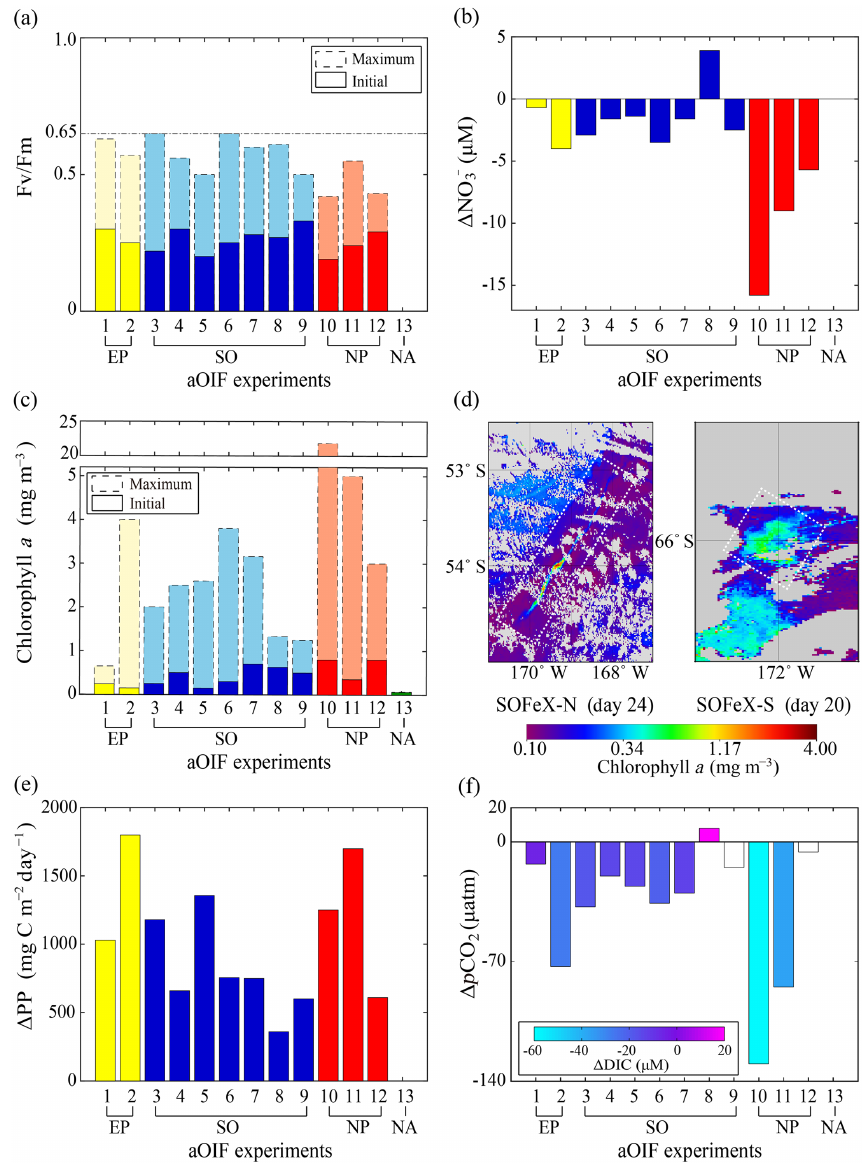
Figure 7. (a) Maximum (bar with dotted line) and initial (bar with solid line) F v /F m ratios during artificial ocean iron fertilization (aOIF) = [ NO − ] −[ NO − ] experiments. (b) Changes in nitrate concentrations ( (cid:49) NO − post − fertilization ( postf ) pre − fertilization ( pref ) ; µM). (c) Maximum 3 3 3 (bar with dotted line) and initial (bar with solid line) chlorophyll a concentrations (mgm − 3 ). (d) Distributions of chlorophyll a concentrations (mgm − 3 ) on day 24 after iron addition in the Southern Ocean iron experiment north (SOFeX-N) from MODIS Terra Level-2 daily image and on day 20 in the Southern Ocean iron experiment south (SOFeX-S) from SeaWiFS Level-2 daily image (white dotted box indicates phytoplankton bloom during aOIF experiments). (e) Changes in primary productivity (PP) ( (cid:49) PP = [ PP ] postf −[ PP ] pref ; mgCm − 2 day − 1 ). (f) Changes in partial pressure of CO 2 ( p CO 2 ) ( (cid:49)p CO 2 = [ p CO 2 ] postf −[ p CO 2 ] pref ; µatm). The color bar indicates changes in dissolved inorganic carbon (DIC) ( (cid:49) DIC = [ DIC ] postf −[ DIC ] pref ; µM). Note that the PP (mgCm − 2 day − 1 ) of aOIF experiment number 1 (IronEx-1) was estimated by multiplying the PP (mgCm − 3 day − 1 ) with the mixed layer depth (initial: 30m and after: 35m). The numbers on the x axis indicate the order of aOIF experiments as given in Fig. 4 and Table 1 and are grouped according to ocean basins: equatorial Pacific (EP) (yellow bar), Southern Ocean (SO) (blue bar), subarctic North Pacific (NP) (red bar), and subtropical North Atlantic (NA) (green bar). Sources are Kolber et al. (1994), Martin et al. (1994), Behrenfeld et al. (1996), Coale et al. (1996, 2004), Steinberg et al. (1998), Boyd et al. (2000, 2004, 2005, 2007), Boyd and Law (2001), Frew et al. (2001), Gall et al. (2001b), Boyd (2002), Gervais et al. (2002), Tsuda et al. (2003), Bakker et al. (2005), Bozec et al. (2005), de Baar et al. (2005), Hiscock and Millero (2005), Smetacek et al. (2005, 2012), Takeda and Tsuda (2005), Tsuda et al. (2005, 2007), Wong et al. (2006), Kudo et al. (2009), Tsumune et al. (2009), Harvey et al. (2010), Smetacek and Naqvi (2010), Berg et al. (2011), Currie et al. (2011), Law et al. (2011), Peloquin et al. (2011b), Thiele et al. (2012), Assmy et al. (2013), Martin et al. (2013), Ebersbach et al. (2014), and Latasa et al.